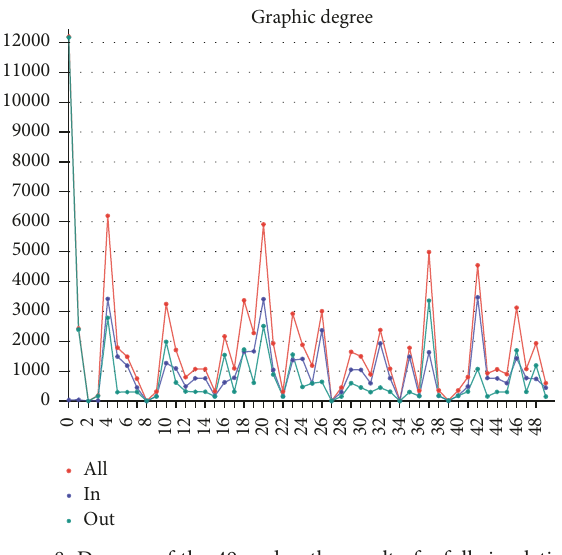
Figure 8: Degrees of the 49 nodes; the result of a full simulation. Degrees, input degree, and output degrees are depicted as a result of the simulation. The degrees are colored red, the input degree is colored blue, and the output degree is colored green.